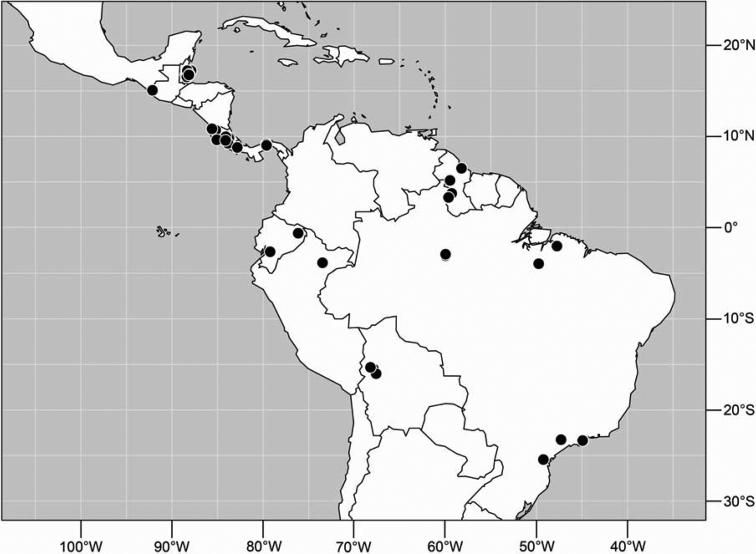
Distribution of Polytrichophora pulchra (Cresson).